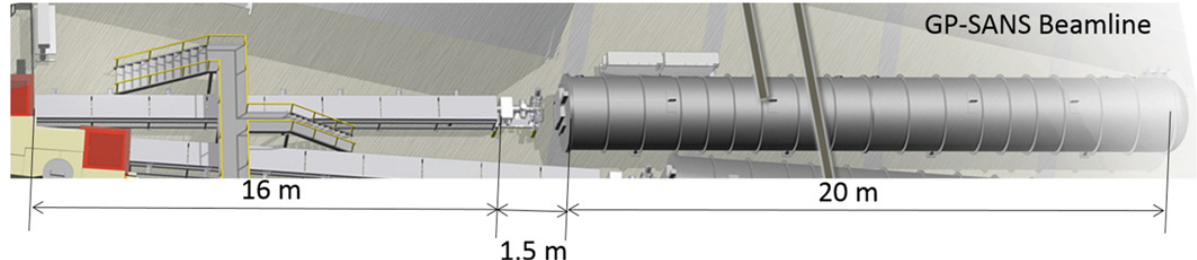
Figure 1. The GP-SANS instrument at HFIR includes a 16 m long collimation vacuum tube, 1.5m long sample region, and 20 m long detector tank.